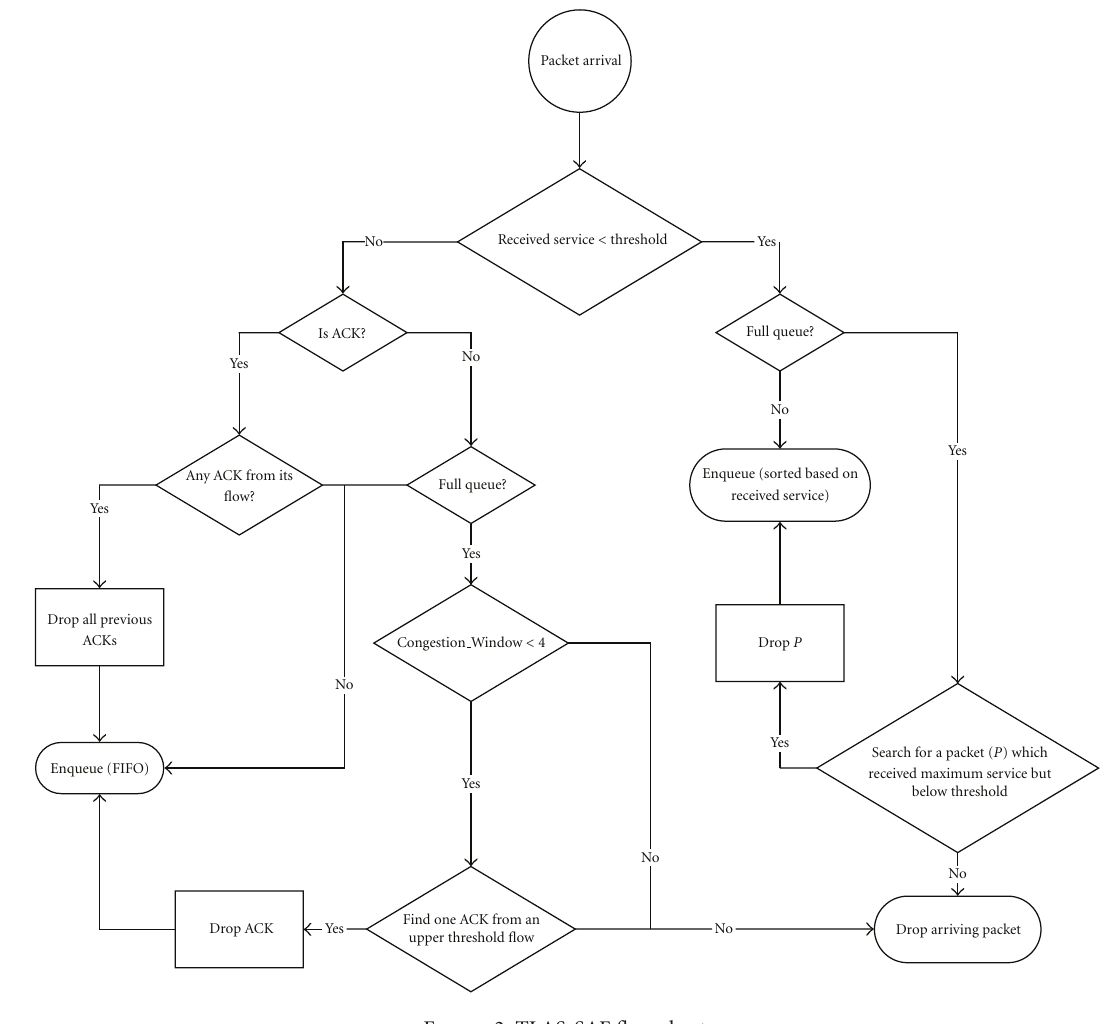
Figure 2: TLAS-SAF flow